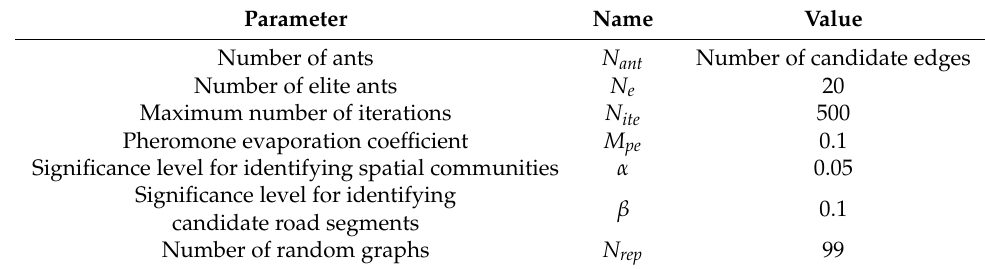
Table 2. Explanation of the parameters and their values used for ant colony